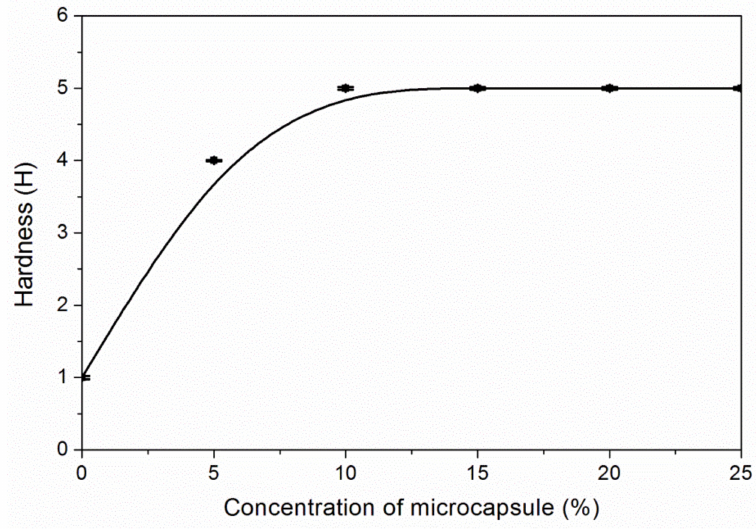
Figure 7. E ff ect of microencapsulation addition on the hardness of waterborne